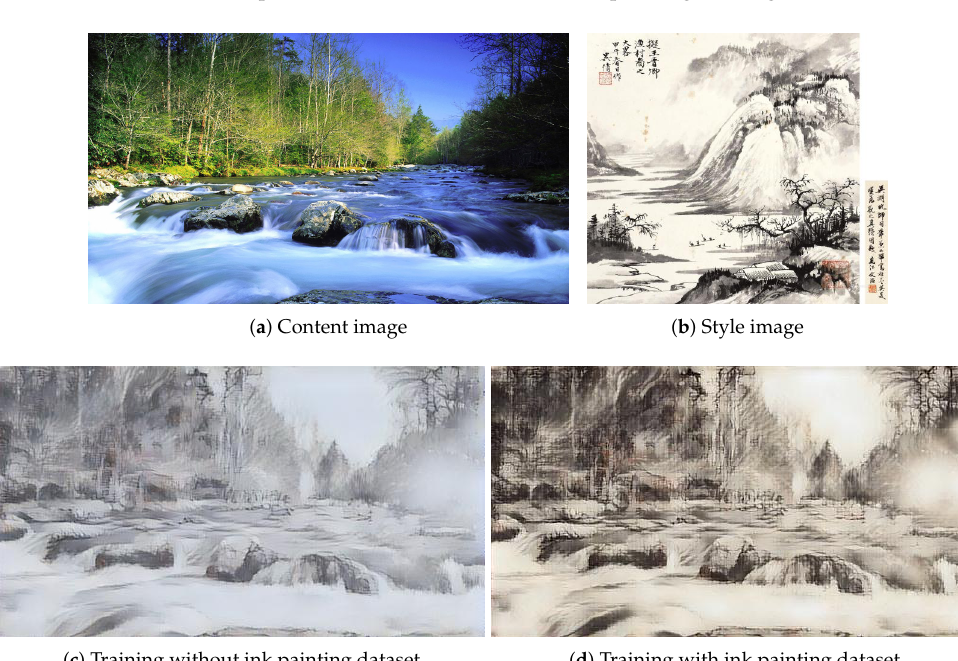
Figure 5. Comparison results with or without ink painting training